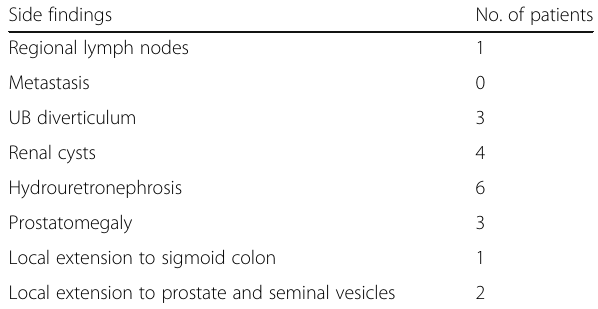
Table 8 Comparison between the sensitivity of the CC and VC as regards the size of the